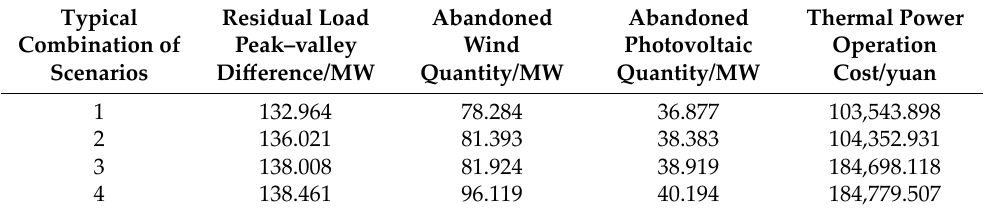
Table 4. Comparison of optimization parameters in different typical